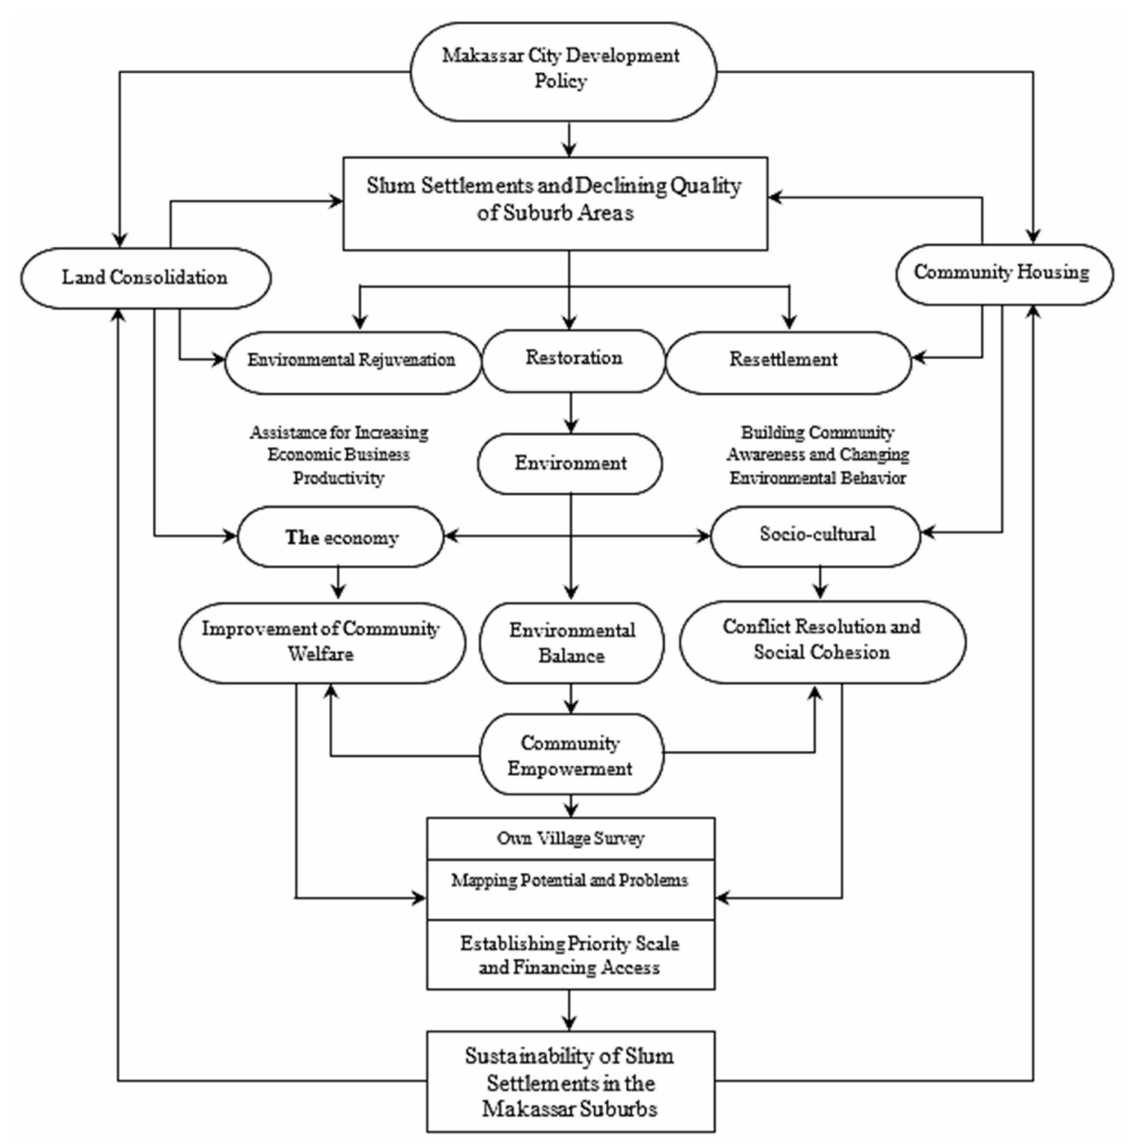
Figure 12. Sustainability of slum settlements in the Makassar